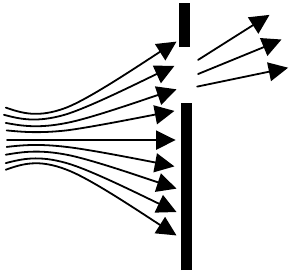
FIG. 1. Schematic of masked beam divergence